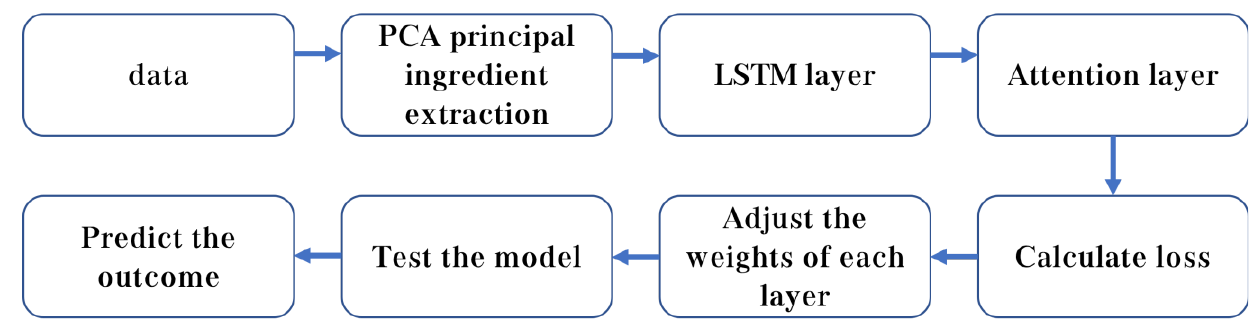
Table 3. Principal component analysis.